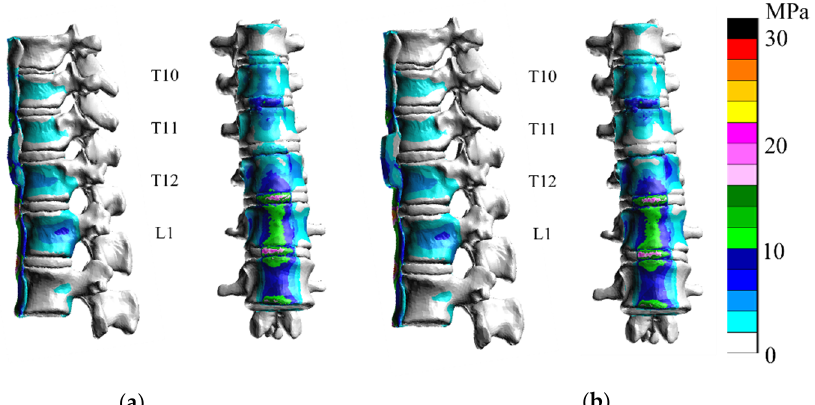
Figure 12. In flexion analyses of T-5 ( a ) and T-10 ( b ), the stress on the intervertebral disc at T11–T12 was reduced, whereas that on the vertebral body was unchanged.